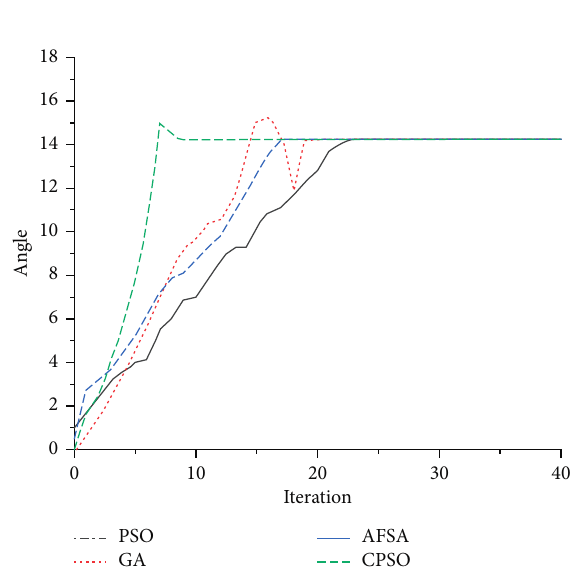
Figure 19: Comparative experiment